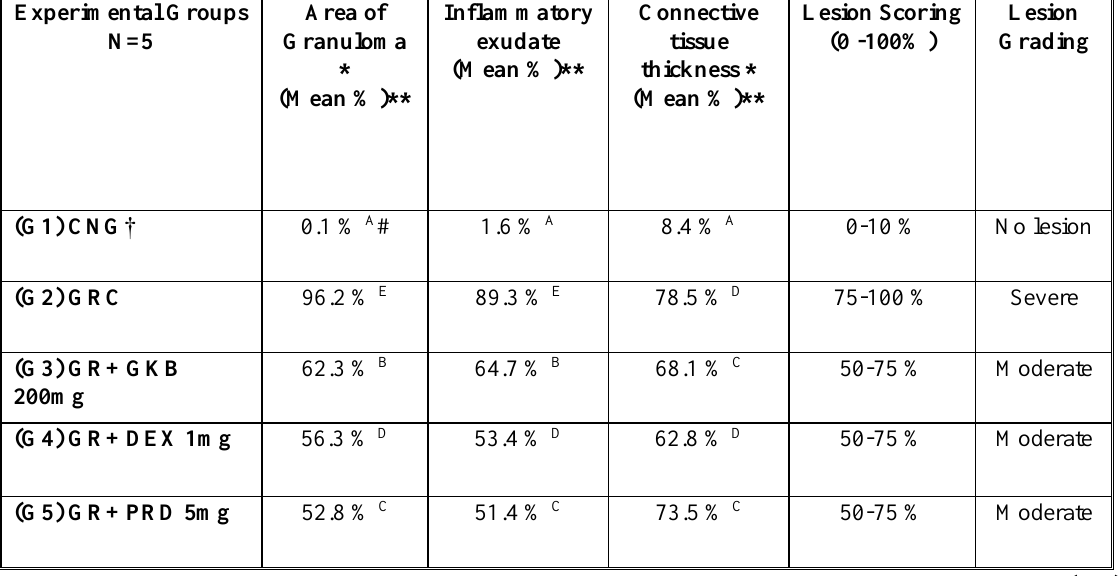
Table 1 .Histological evaluation of granuloma lesion Experimental